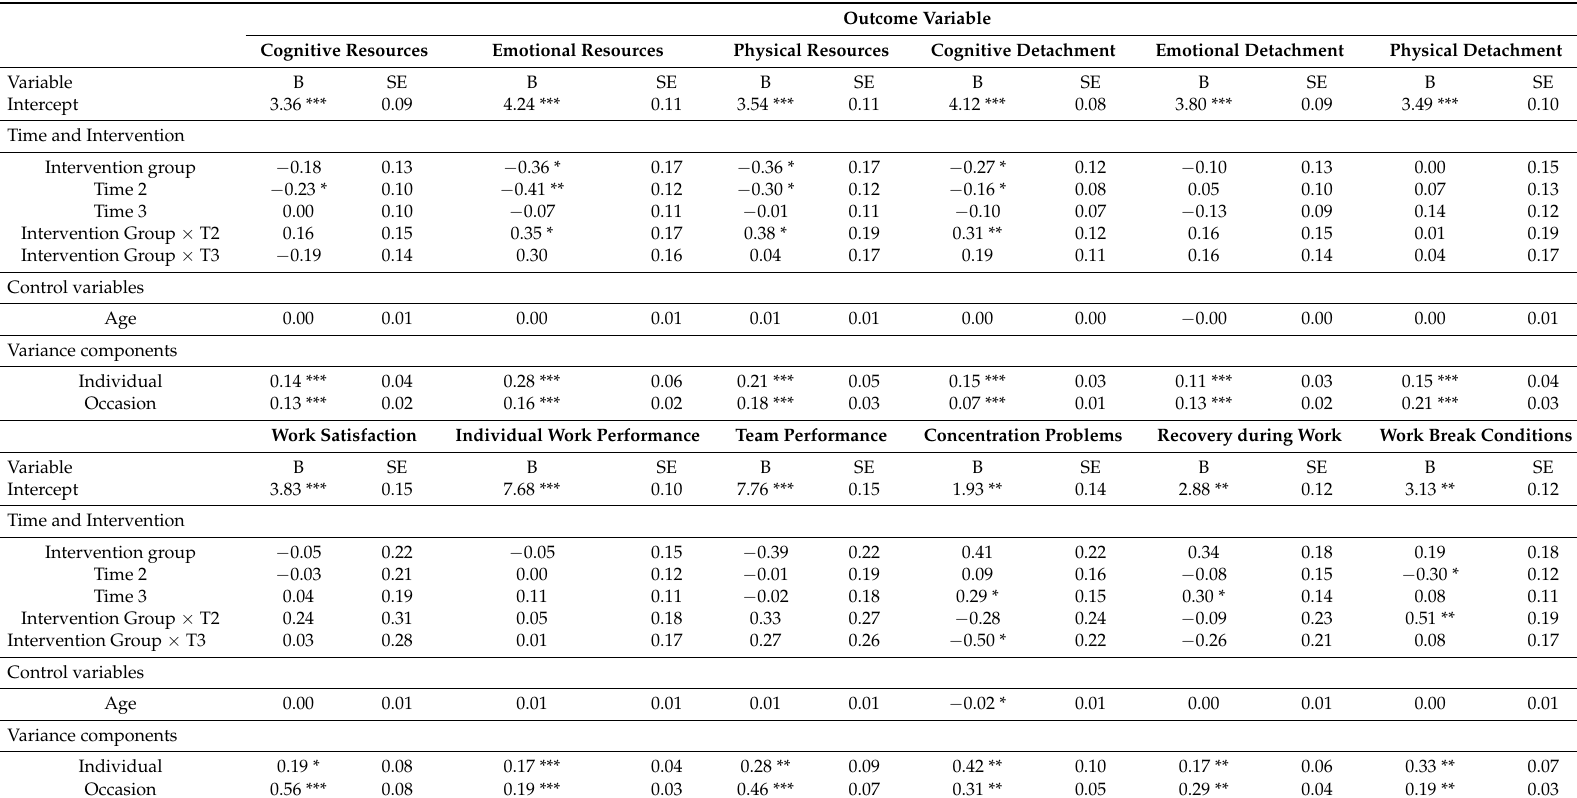
Table A3. Multilevel models for change over time and intervention effects within the nursing department ( N = 60 at Time